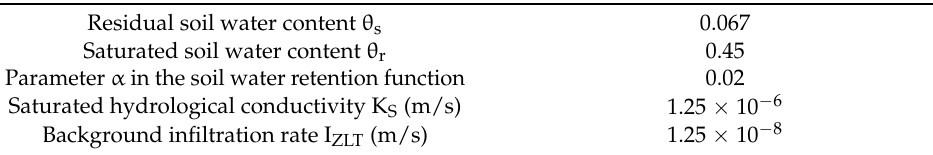
Table 2. Input hydraulic parameters used in the